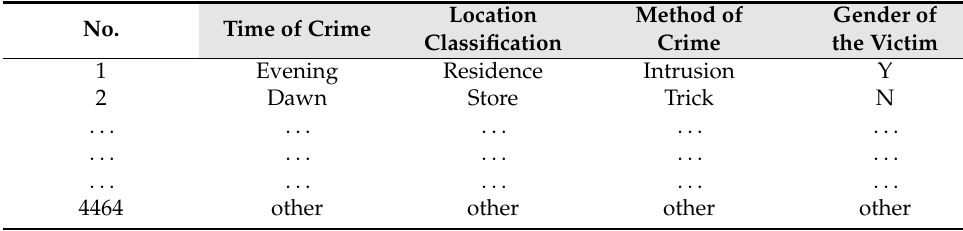
Table 1. The analysis environment was then built for k-modes clustering using Python 3.7.6. Table 1. Dataset for K-modes clustering. No. Time of Crime